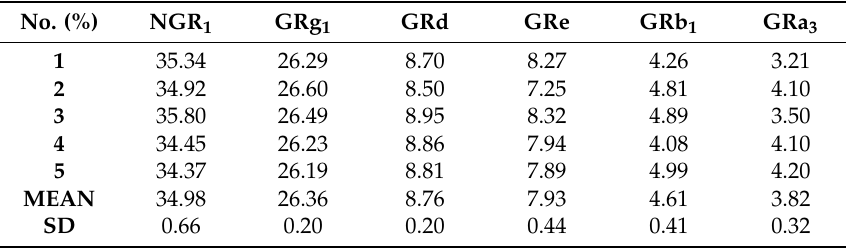
Table 1. The contents of six saponins in panax ginseng saponins